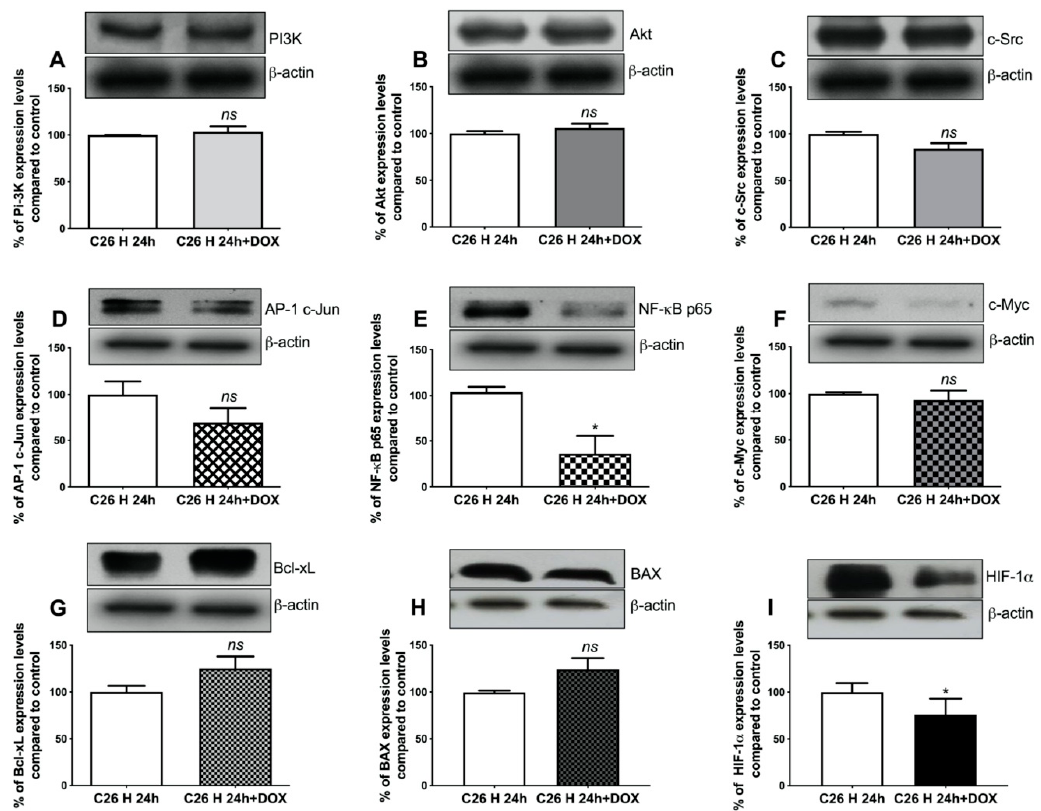
Figure 7. Overview on the molecular changes in hypoxic C26 cells to DOX treatment. Cropped Western blot images and their representative graphs displaying the percentage of protein levels after 24 h treatment with 0.3 µ M DOX under hypoxia compared to controls (the levels of the same proteins in untreated cell lysates) are shown for PI3K in panel ( A ); for Akt in panel ( B ); for c-Src in panel ( C ); for AP-1 c-Jun (the c-Jun subunit of AP-1 transcription factor) in panel ( D ); for NF- κ B p65 (the p65 subunit of the NF- κ B transcription factor) in panel ( E ); for c-Myc in panel ( F ); for Bcl-xL in panel ( G ), for BAX in panel ( H ); and for HIF-1 α in panel ( I ). β -actin was used as loading control. Data were